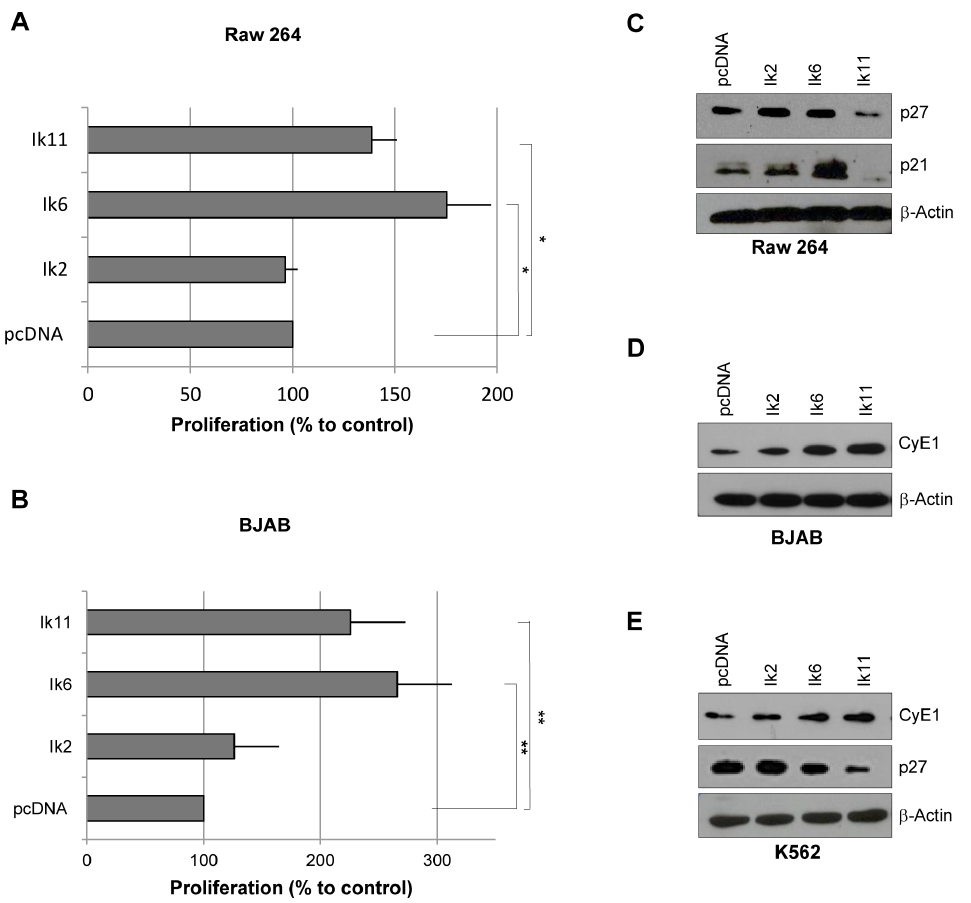
Figure 5. Ik11 overexpression promotes cell proliferation. ( A–B ) Analysis of cell proliferation in Raw 264 (A) and BJAB (B) cell lines. Cells were transfected with pcDNA3.1-Ik2, pcDNA3.1-Ik6, pcDNA3.1-Ik11 or empty vector. Proliferation was determined by the MTS assay at 24 h (BJAB) or 48 h (RAW 264) and calculated as the percent of control (pcDNA3.1). Mean 6 SD is shown (* p , 0.05; ** p , 0.001). Data shown are representative of three different experiments. ( C–E ) Western blot analysis of p27, p21 and cyclin E in RAW 264 (C), BJAB (D) and K562 (E) cell